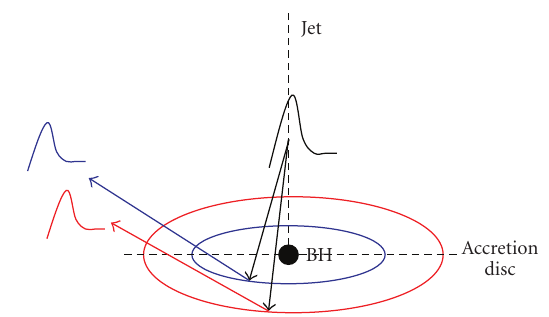
Figure 5: Reverberation in the accretion disc around the central BH of QSO 0957 +